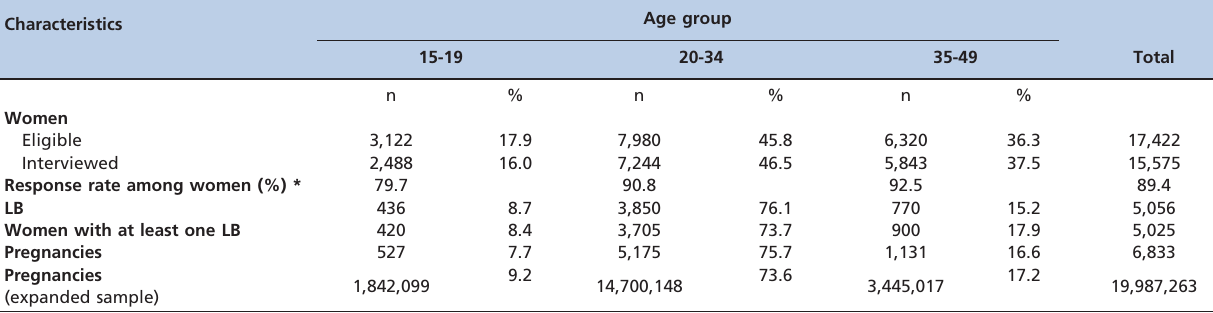
Table 1 - Response rates and live births by age group. DHS, Brazil, 2006. Characteristics